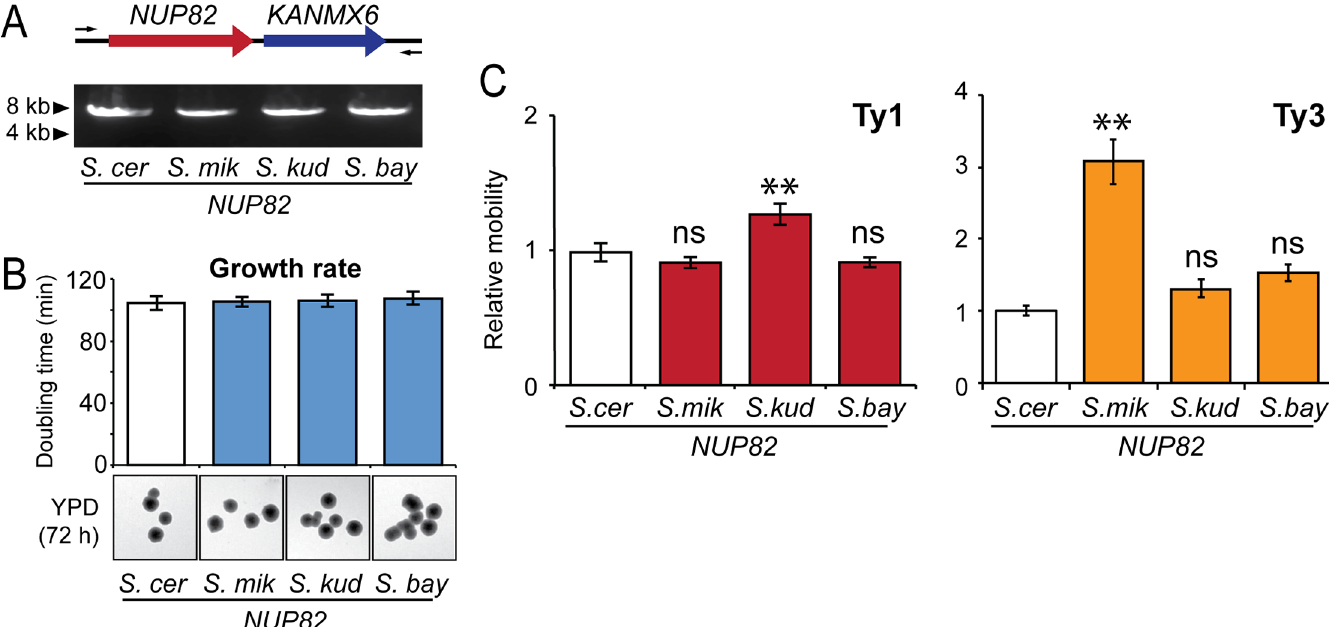
Fig 7. The evolution of NUP82 and its effect on Ty1 and Ty3 mobility within S . cerevisiae . (A) A schematic representation of S . cerevisiae engineered to express NUP82 from different Saccharomyces species. Genome engineering was confirmed by PCR amplification across the NUP82 locus. (B) The doubling time of NUP82 - complemented strains in a liquid medium. Colony growth and morphology of the engineered strains was monitored for 72 h on a solid YPD medium (error bars: standard error, n > 3). (C) Relative mobility of Ty1 and Ty3 within strains complemented with NUP82 from different Saccharomyces species. Asterisks mark significant differences in Ty mobility compared to the strain encoding NUP82 from S . cerevisiae (error bars: standard error, n > 3; (cid:3)(cid:3) Tukey–Kramer method, p < 0.05).